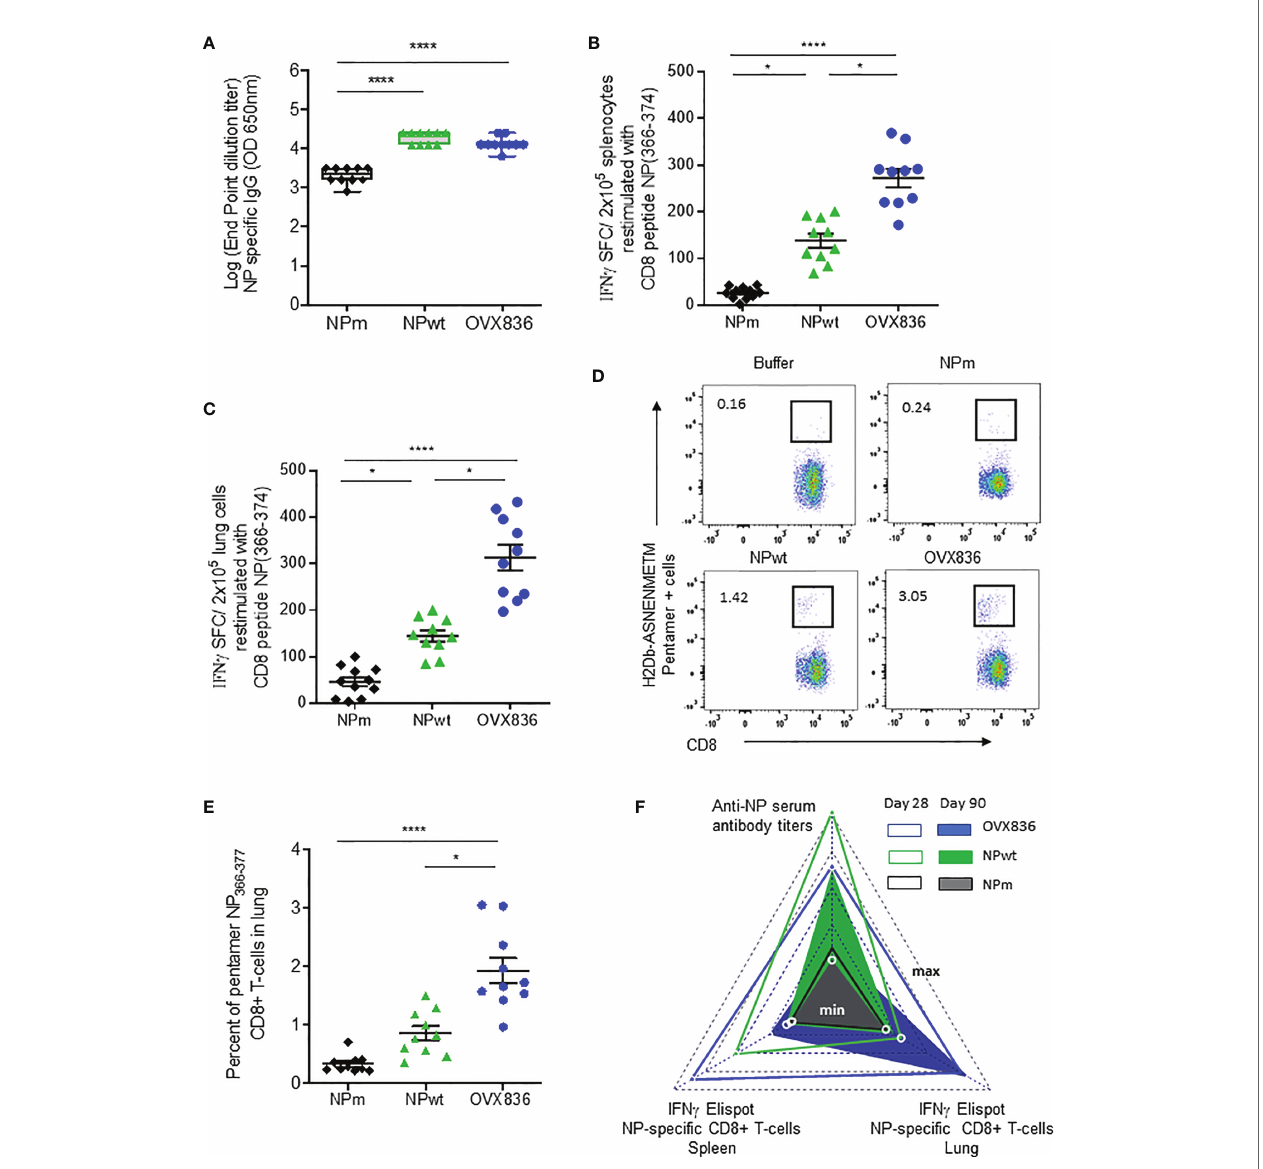
FIGURE 2 | OVX836 vaccine induces higher numbers of persistent NP-speci fi c CD8+ T-cells in lung tissue and spleen compared to NPm and NPwt. C57BL/6 female mice (n = 10) were immunized twice (D0, D21) with 30 µg of NPm, NPwt, and OVX836 by the IM route. (A) NP-speci fi c IgG were measured by ELISA in serum at D28. Levels of IgG are expressed as Log (endpoint dilution titer) and represented in box-and-whisker plots. (B, C) NP 366 – 374 -speci fi c IFN g secreting T-cells (spot-forming cells (SFC)/2 × 10 5 cells) were measured by ELISpot in the spleen (B) and in the lung (C) at D28. (D, E) In the lung tissue, NP 366 – 374 -speci fi c CD8+ T- cells were detected by fl ow cytometry using pentamer staining (H2Db-NP 366 – 374 ). Representative fl ow cytometry plots show frequencies of NP 366 – 374 -speci fi c CD3+CD8+ T-cells in the lung (D) . Percentage of NP 366 – 374 -speci fi c CD3+CD8+ T-cells in the lungs of mice (E) . Individual data, mean (line), and SEM are represented, n = 10 mice per group in two independent experiments. Differences were assessed by one-way ANOVA followed by Tukey ’ s multiple comparison test or with a Kruskal – Wallis test followed by Dunn ’ s multiple comparison test. *p < 0.05; **** for p < 0.0001. (F) Radar chart presents the minimum (min) and maximum (max) values for each assay as indicated in log10 scale. Comparing the mean of antigen-speci fi c immune responses at D28 (empty triangle) and D90 (plain triangle): NPm (black), NPwt (green), and OVX836